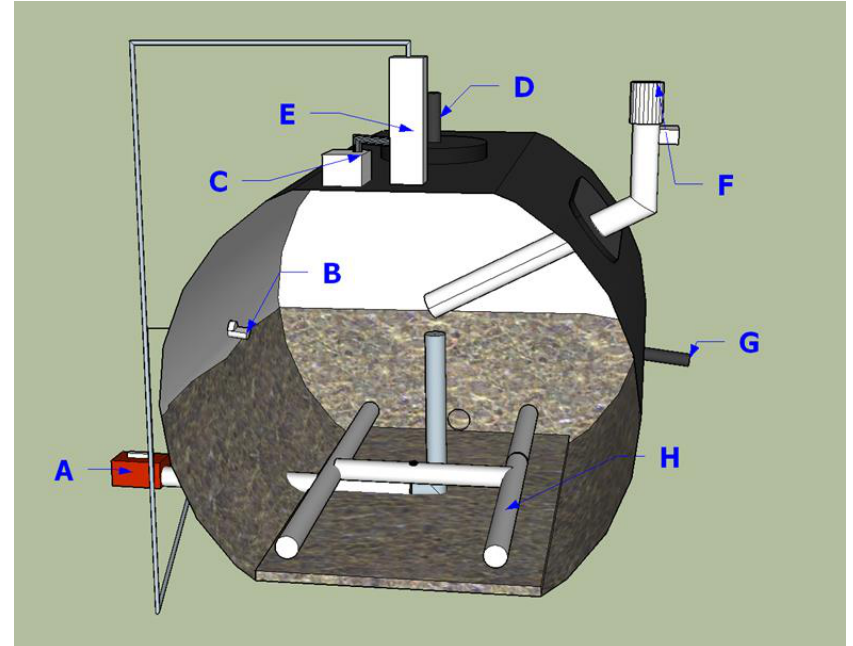
Figure 1. Cutaway schematic of a micro-aerated digester: (A) Waste outlet valve; (B) Float level switch; (C) Air pump; (D) Gas sampling port; (E) Flow meter for aeration; (F) Feed inlet; (G) Wastewater sampling port; (H) Aeration “H” -manifold.